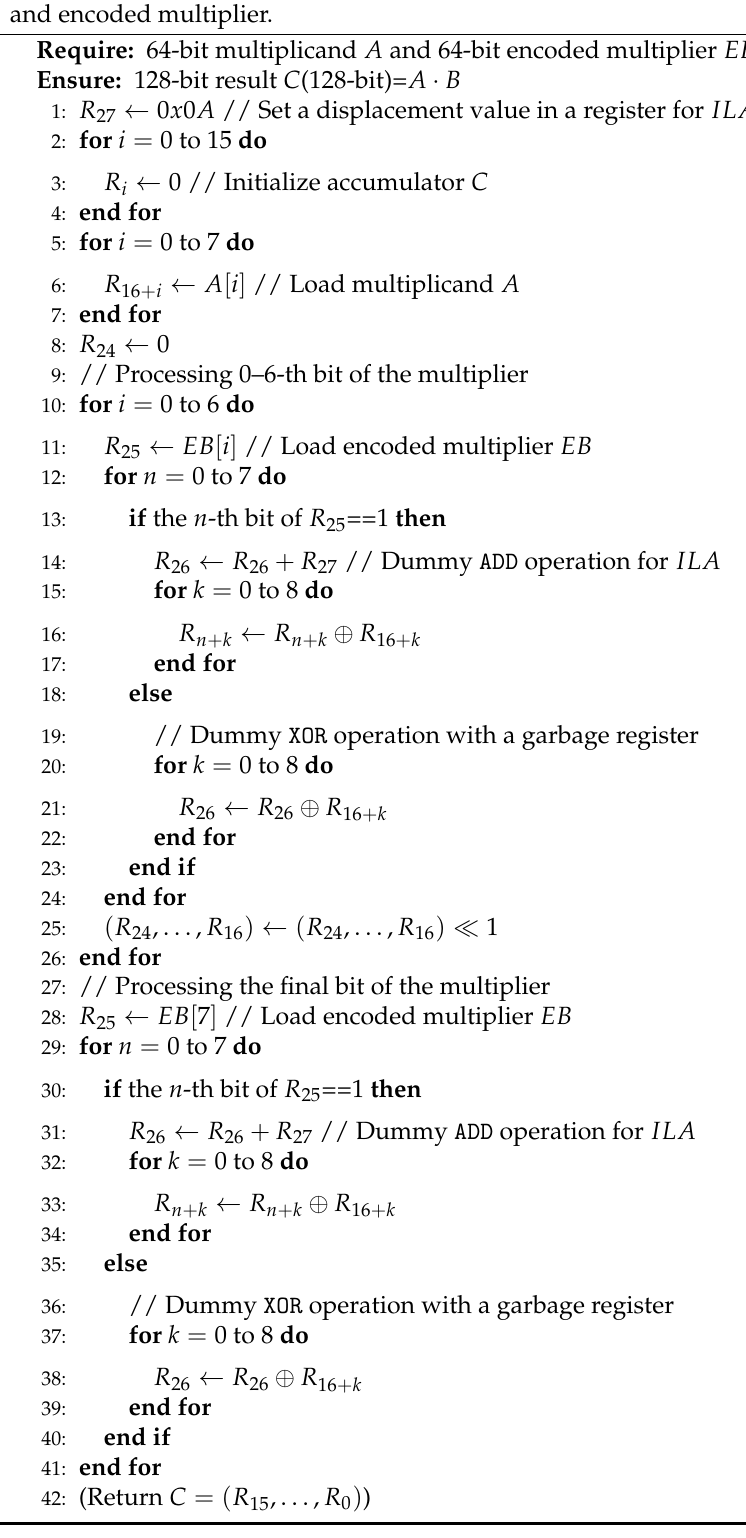
Algorithm 3: Proposed 64-bit Block-Comb technique with the bit-reordering technique where ( R 15 , . . . , R 0 ), ( R 24 , . . . , R 16 ), and ( R 25 ) are used for the accumulator, multiplicand, and encoded